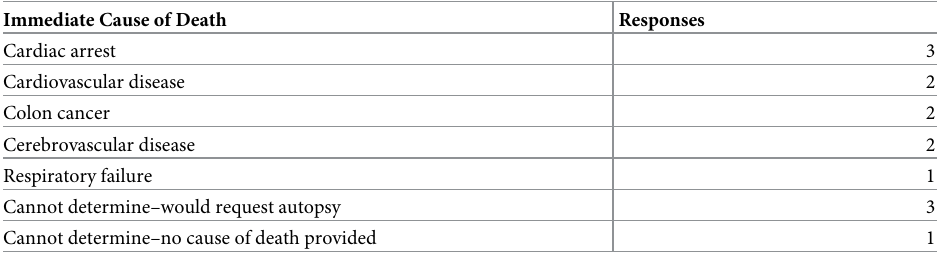
Table 2. Cause of death selected for the case